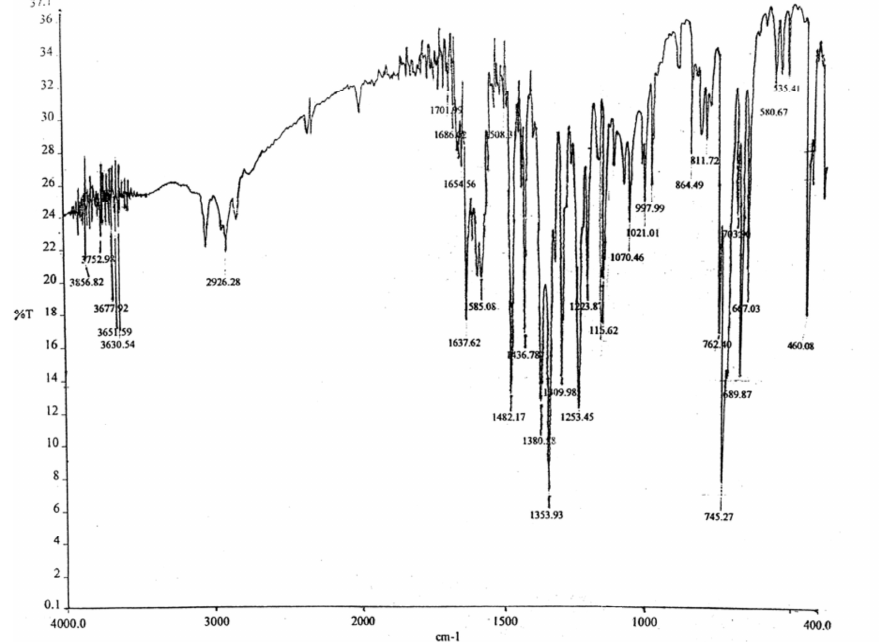
Figure 2. FT-IR spactra of Triphenylanytimony(V)- o